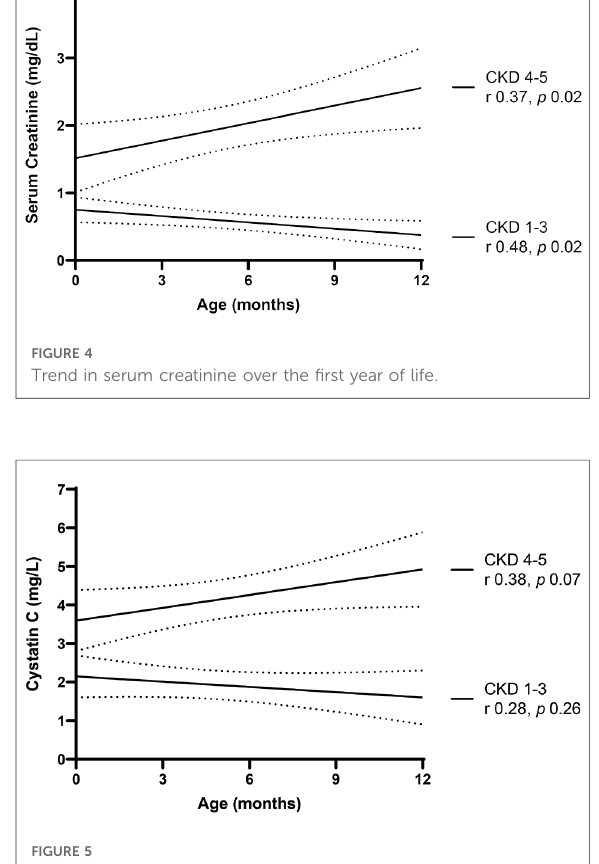
FIGURE 5 Trend in serum cystatin C over the fi rst year of life.